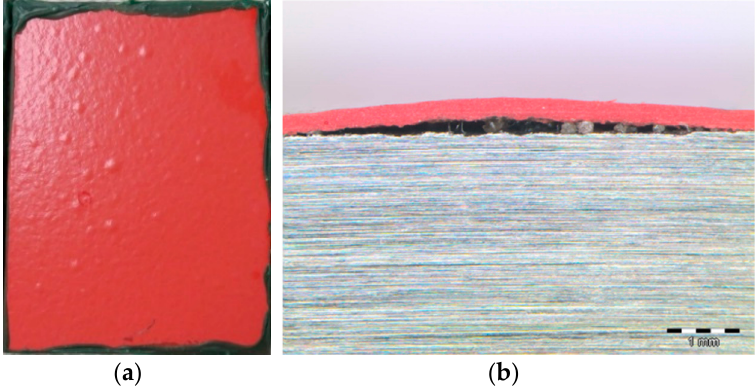
Figure 3. Optical microscopies of the C1 coating surface showing isolated ferric corrosion pits.